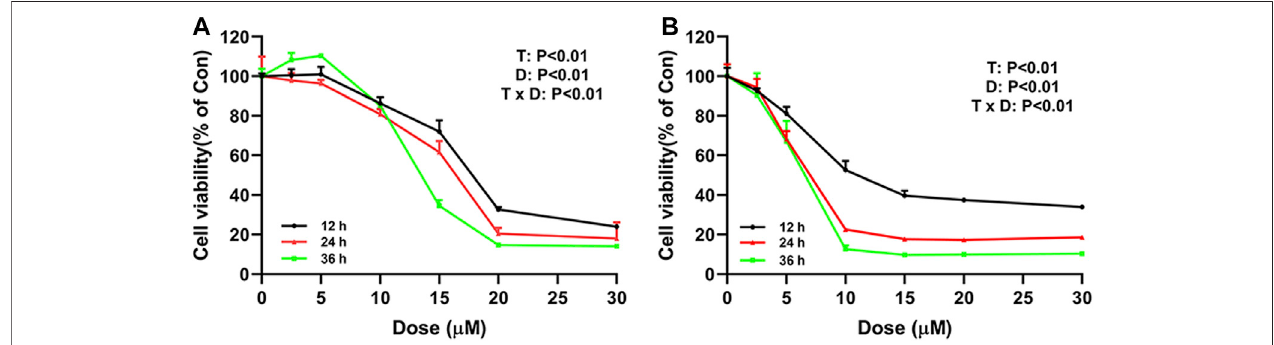
FIGURE 2 | Ivermectin inhibits cell proliferation of SW480 and SW1116 cells. SW480 (A) and SW1116 cells (B) were cultured at different concentrations of ivermectin (0, 2.5, 5, 10, 15, 20, and 30 μ M) for 12, 24, and 36 h, and then CCK-8 assay was performed to detect the cell proliferation. The experiment was repeated three times, and data were presented as mean ± S.E.M. The interaction between dose (D) and time (T) effect were analyzed using two-way ANOVA following Tukey ’ s t -test. D: dose effect; T: time effect: T × D: the interaction between time and dose effect.